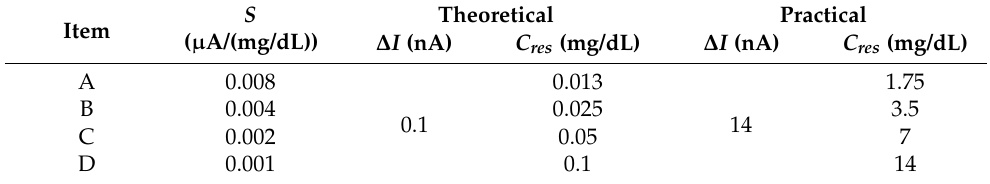
Figure 11. Current fluctuation measurement of the proposed system. Table 1. The resolution of the doped/undoped NWGS.